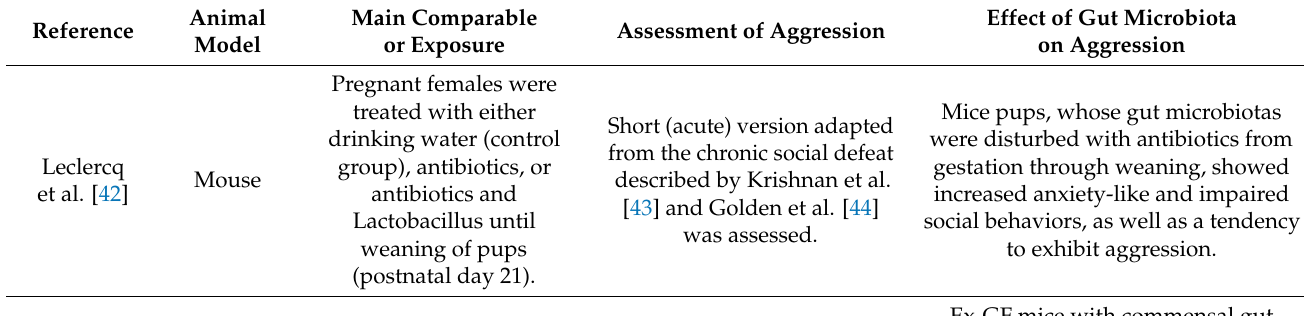
Table 1. Research on aggressive behaviors associated with gut microbiota in